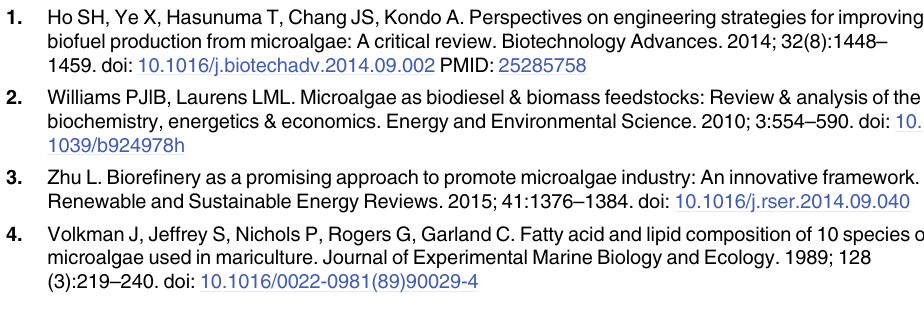
S1 Fig. Flowchart displaying the assembly and annotation pipeline. S2 Fig. RNA integrity during the growth phases for the time course samples. S1 Table. qPCR primers designed for selected target transcripts. “ LA ” designates Long Amplicons used to create quantitative standards for